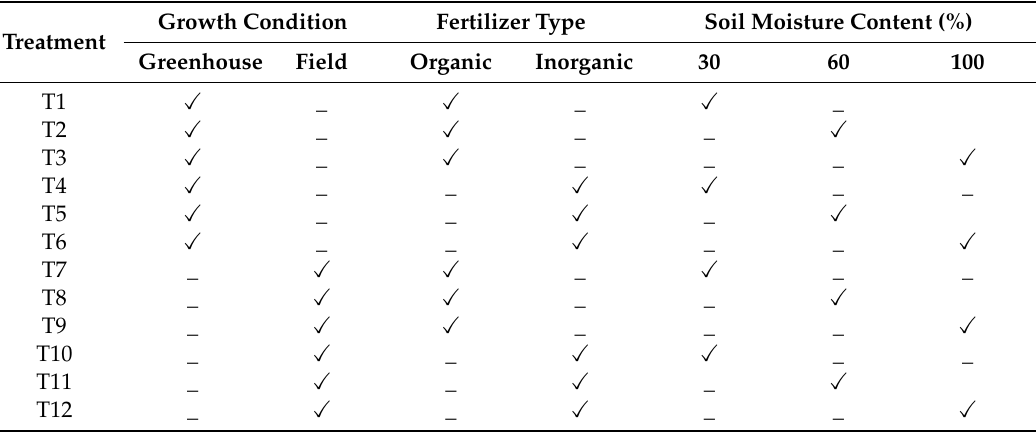
Table 1. Treatments